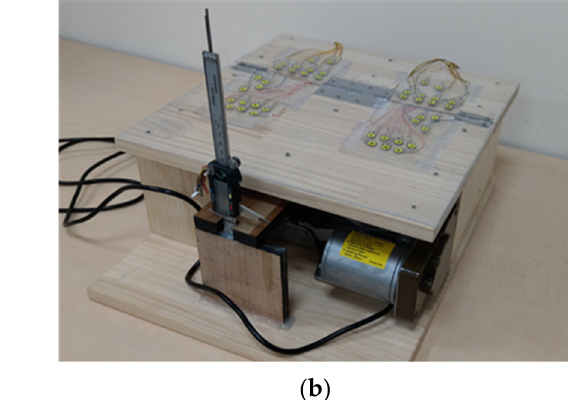
Figure 1. ( a ) Block diagram of the measurement platform; ( b ) Photograph of the measurement platform.